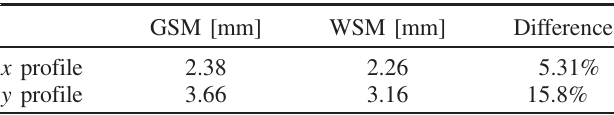
TABLE II. Comparison of the rms values obtained by the gas sheet monitor (GSM) and the wire scanner monitor (WSM).